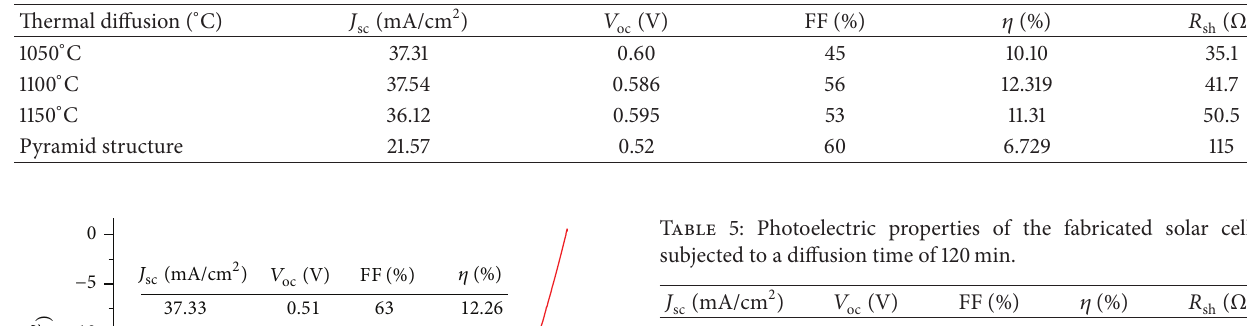
Table 4: Photoelectric properties of the fabricated solar cells subjected to various diffusion temperatures.